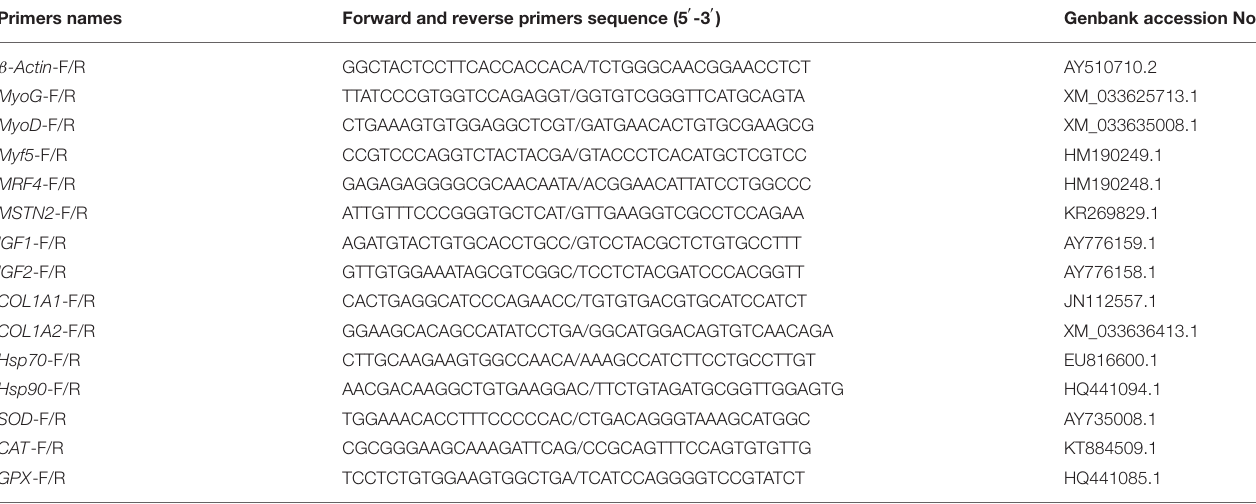
TABLE 2 | Primers sequences used for RT-qPCR.